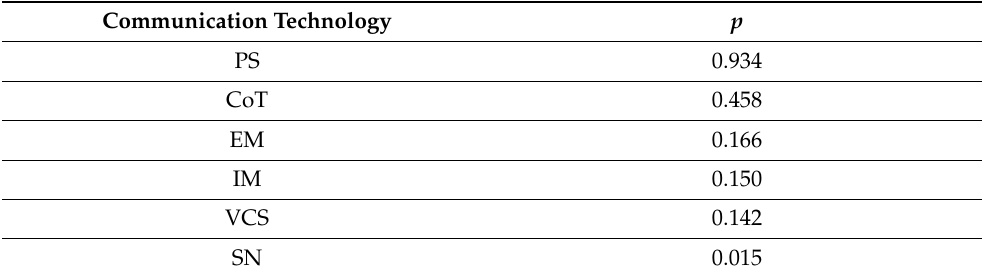
Table 12. Results of statistical inference t-test to verify the independence of students’ and teachers’ answers to question 7 about the ease of use of the communication technologies ( p ≤ 0.05).